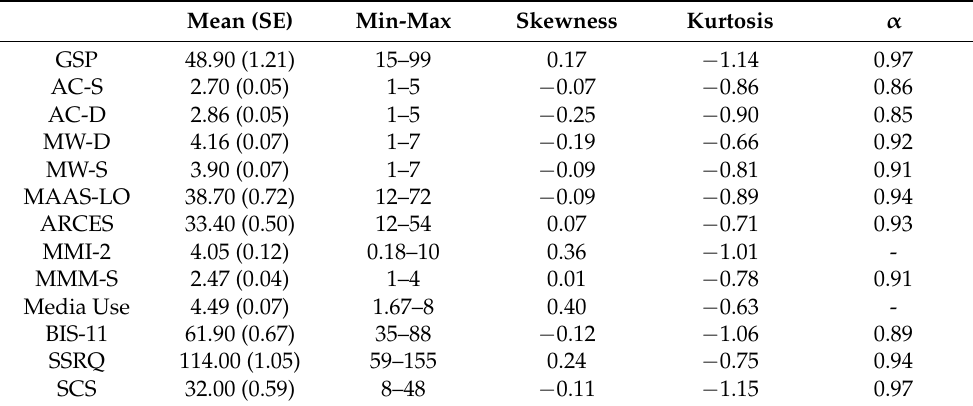
Table 1. Summary of means, standard deviations, ranges, skewness, kurtosis, and Cronbach’s alphas for survey measures ( N =